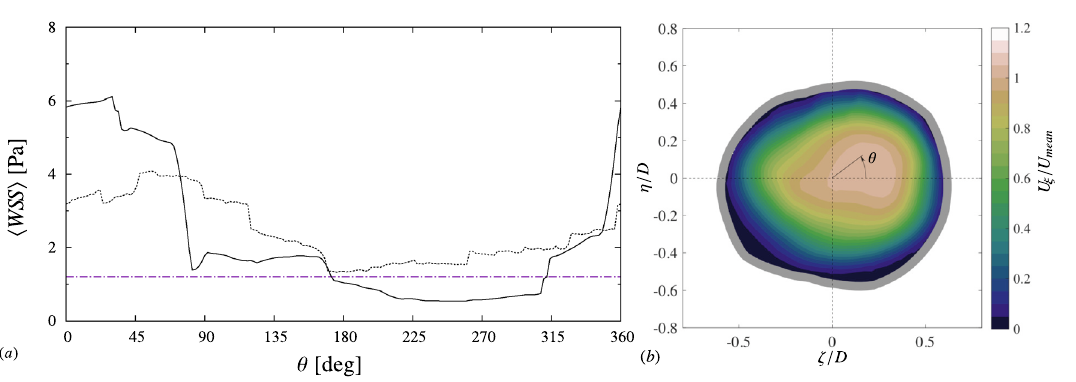
Figure 5. Flow and WSS variability over the cross-sectional lumen area (at s / D = 12.5 ). ( a ) Time-averaged (cid:31) WSS (cid:30) as a function of the azimuthal direction θ : — realistic centerline; —– straight centerline. The horizontal line (–.–) denotes the adhesion threshold for neutrophils ( 1.2Pa ). ( b ) Mean streamwise velocity U ξ over the lumen area for the realistic centerline